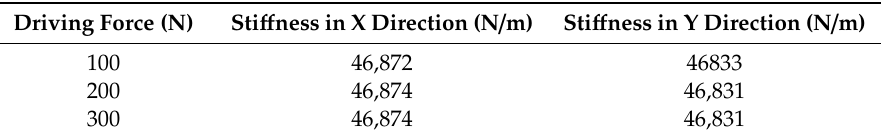
Table 2. Micro-positioning platform simulation stiffness table.